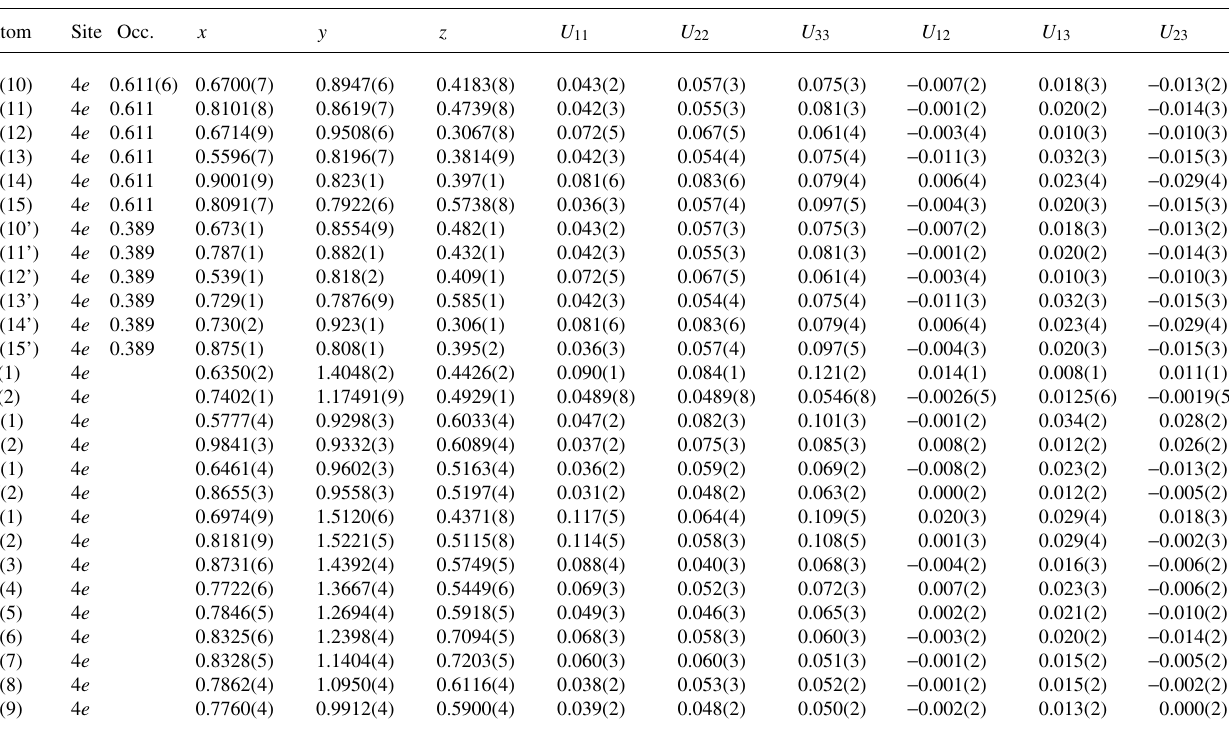
Table 3. Atomic coordinates and displacement parameters (in Å 2 ) . Atom Site Occ.